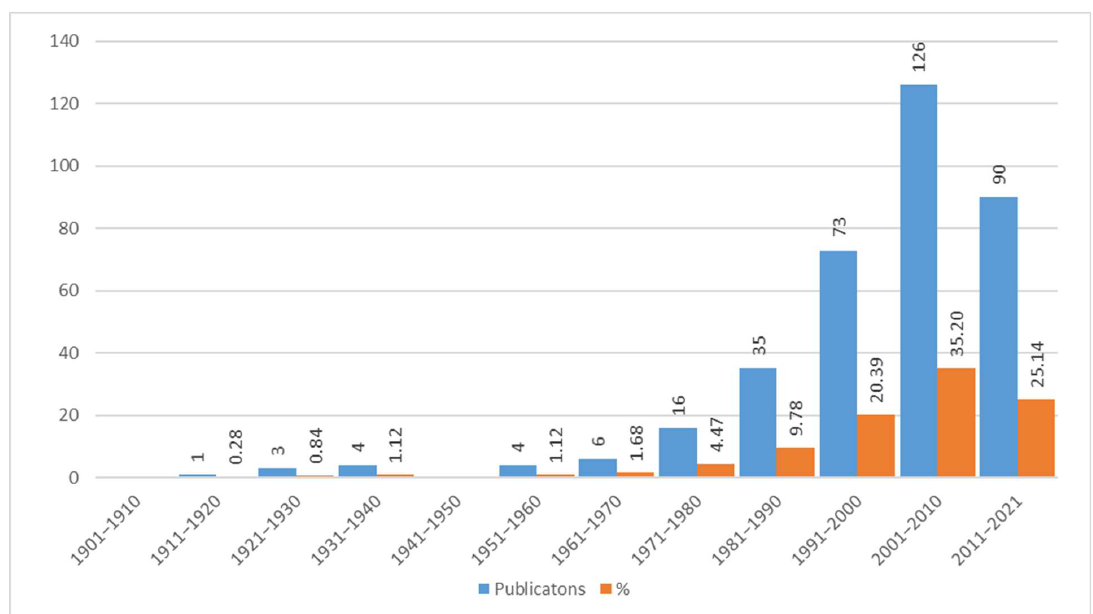
Figure 16. Publications (358) on the alimurgic theme per decade, expressed in absolute and percentage figures.